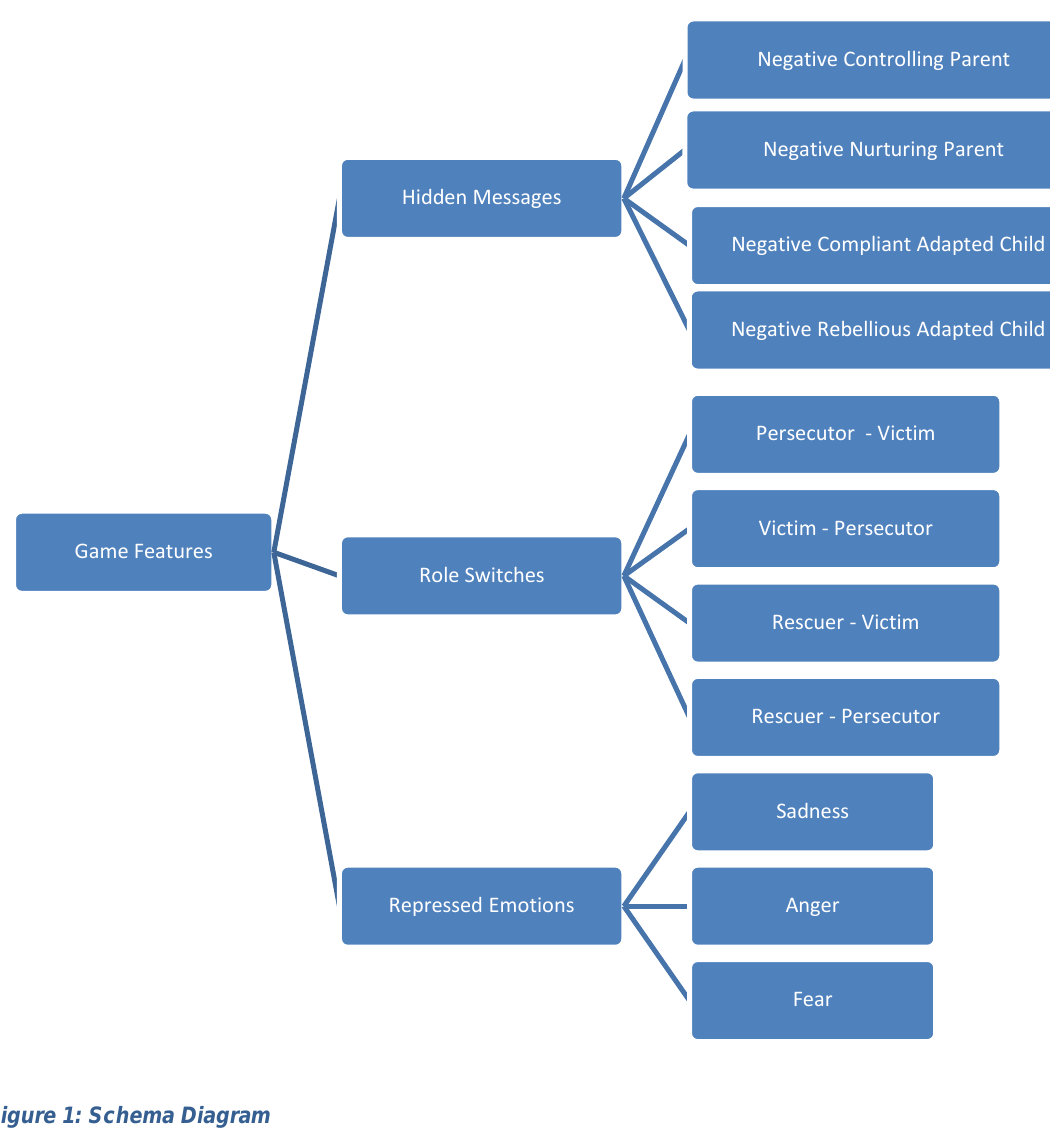
Figure 1: Schema Diagram